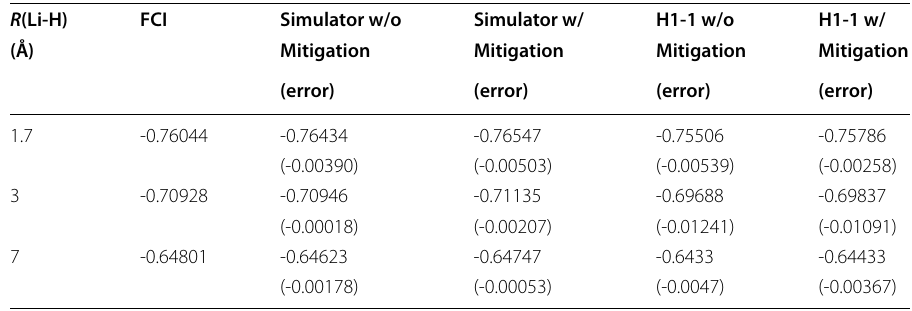
Table 1 Total energies in Hartree for LiH using the 1 COVO basis set for VQE simulations and hardware calculations on the Quantinuum H1-1 quantum computer. A simple-cubic supercell (L 15.0 Å) was used. Values in parenthesis are error relative to =